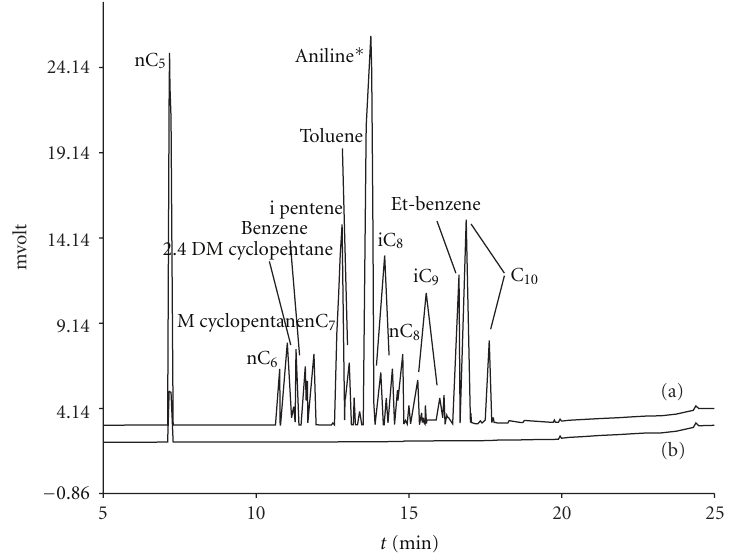
Figure 9: Comparison of chromatograms for degradation of aniline and other compounds in real petroleum refinery wastewater (catalyst concentration: 100 mg/L, initial PH: 7, temperature ( T ): 293K, and irradiation time: